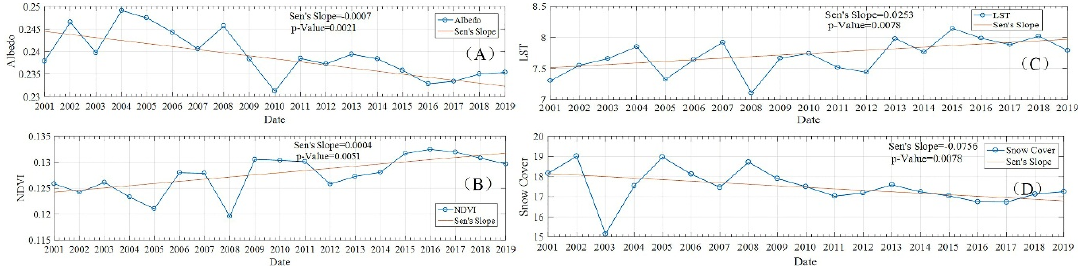
Figure 5. The evolution of the monthly averaged albedo ( A ), land surface temperature (LST), normalized difference vegetation index (NDVI) ( B ), and the fraction of snow cover anomaly ( C ).